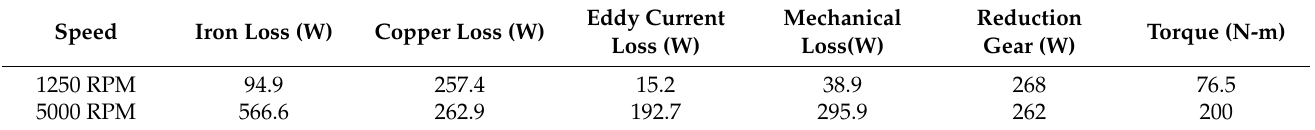
Table 3. Values of generated